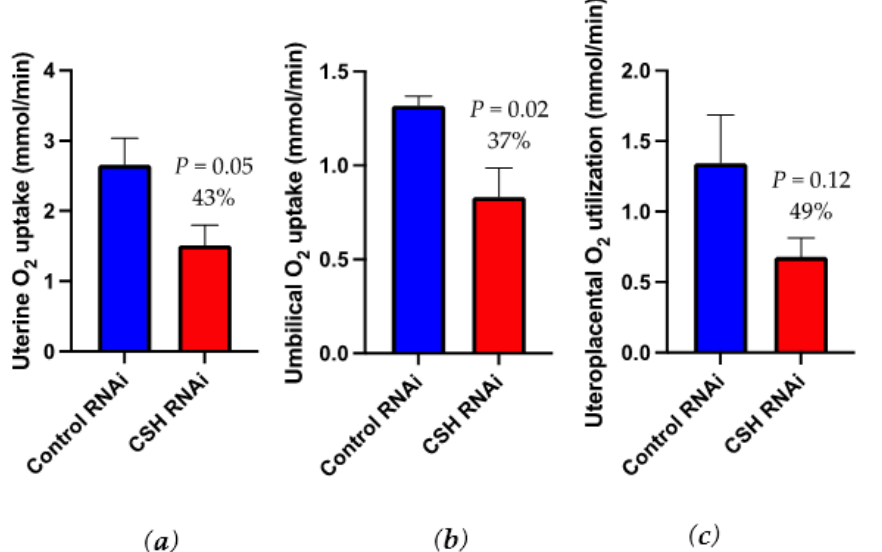
Figure 3. Uterine, umbilical, and uteroplacental oxygen uptakes as assessed by 3 H 2 0 transplacental diffusion at 130 dGA: ( a ) uterine oxygen uptakes, mmol/min ( b ) umbilical oxygen uptakes, mmol/min; ( c ) uteroplacental oxygen utilization, mmol/min. Data are shown as means ± SEM for all pregnancies in each treatment group. CSH, chorionic somatomammotropin; RNAi, RNA interference. Table 4. In vivo measurements of nutrient transfer and uptake based on the 3 H 2 0 transplacental diffusion technique.